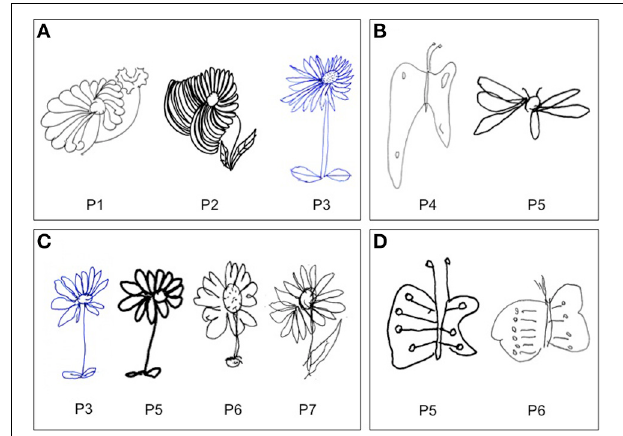
FIGURE 2 | Examples of drawing from memory (A, P#1, P#2, and P#3: daisy), (B, P#4 and P#5: butterfly) and by copy (C, P#3, P#5, P#6, and P#7: daisy), (D, P#5 and P#6: butterfly). Patients showed a contralesional productive behavior, characterized by systematic left-sided expansion of drawings both by copying and from memory and addition of more left-sided details to the drawn object, contralateral to the side of the lesion.